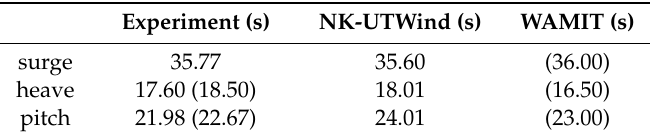
Table 9. Comparison of measured and numerical natural periods.